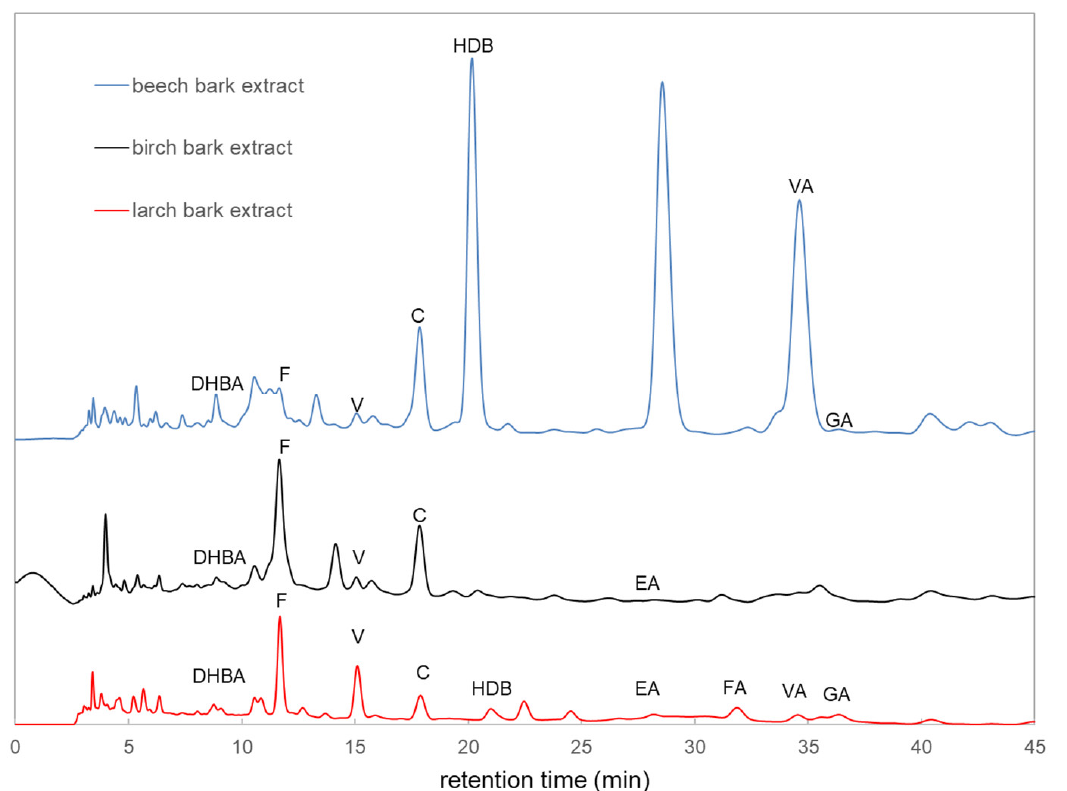
Figure 1. Chromatograms of bark extracts from larch, birch and beech trees. Different substances of DHBA (dihydroxybenzoic acid), HBA (hydroxybenzoic acid), F (unknown flavonoids), V (Vanillin), C (catechin), EA (ellagic acid), FA (ferulic acid), VA (vanillin acid) and GA (gallic acid) were deter- mined.